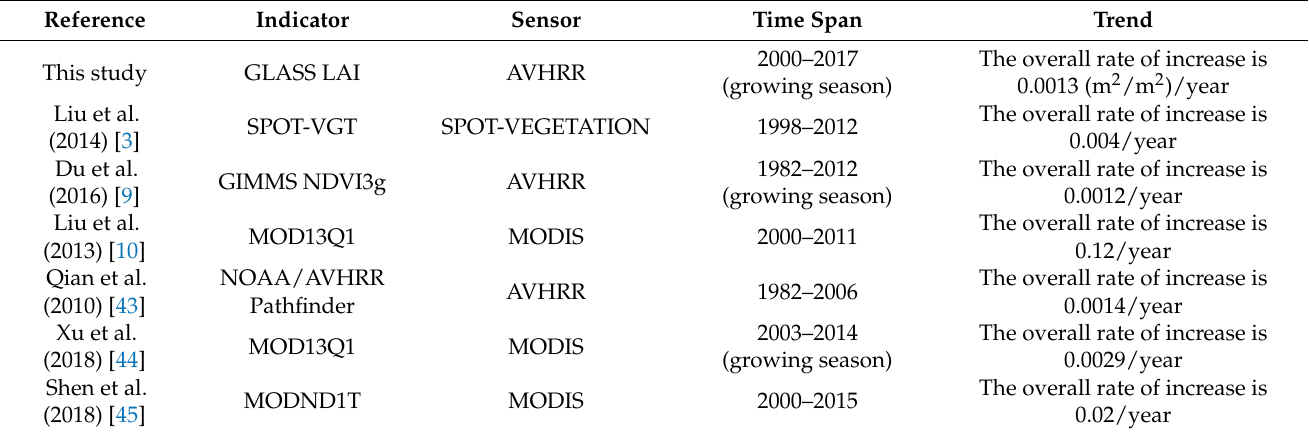
Table 1. A Comparison between this study and previous